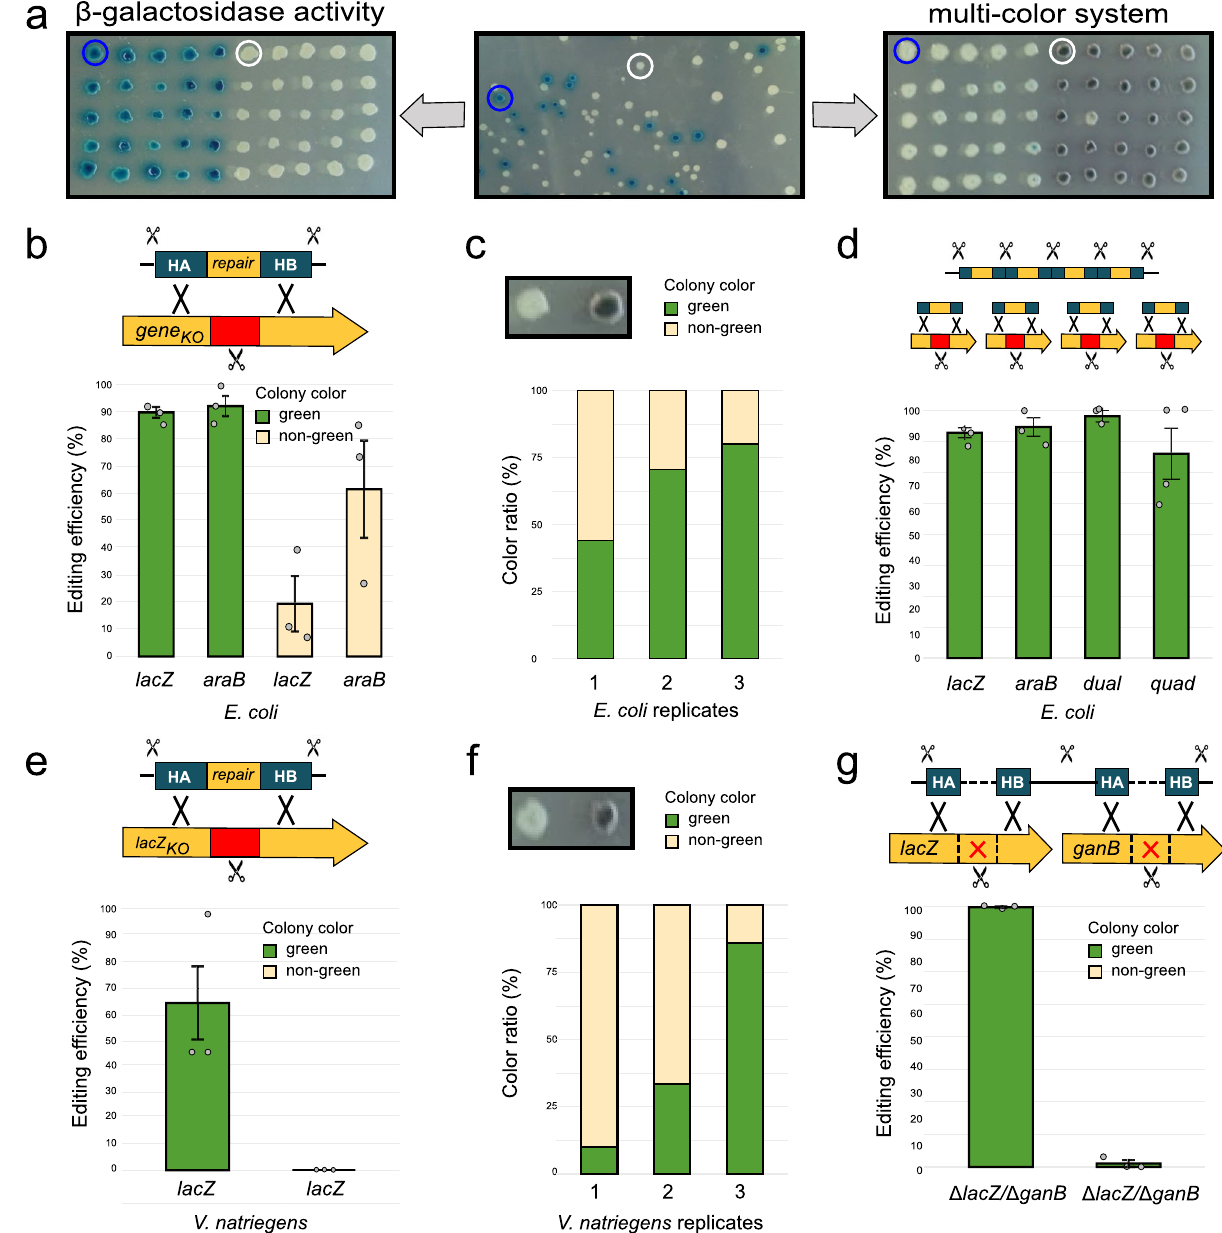
Fig. 4 Editing ef fi ciency of CRISPR SWAPnDROP in three species. a Test of the multi-colour system by a β -galactosidase knockout in Dickeya dadantii . In the left panel, β -galactosidase positive and negative colonies are picked after editing (centre panel) and grown at 37 ∘ C on LB agar supplemented with IPTG and X-Gal. The same colonies were also transferred to a second plate and grown on LB at 30 ∘ C to develop the green colour (right panel). Circles indicate identical colonies on three plates. White colonies in the left and centre panels indicate successful editing. b Shown is the editing ef fi ciency of green and non-green colonies for the reconstituted lacZ and araB genes in E. coli . Experiments were carried out in triplicates. 45 green and 45 non-green colonies were tested in total for both lacZ and araB reconstitution. Data are presented as mean values± SEM. c Shown is the colour distribution of colonies in three different lacZ reconstitution experiments. d Shown is the editing ef fi ciency of green colonies of single and multiplex editing. Error bars represent the standard error. Experiments were carried out in triplicates, except for the quadruple edit, which was carried out in quadruplicates. For dual editing ( lacZ and araB ), 45 colonies and for the quadruple edit ( lacZ , araB , xylA and dapA ), 40 colonies were tested in total. Data are presented as mean values ± SEM. e Shown is the editing ef fi ciency of green and non-green colonies for the reconstituted lacZ gene in V. natriegens . Experiments were carried out in triplicates. In total, 43 green and 32 non-green colonies were tested. Data are presented as mean values ± SEM. f Shown is the colour distribution of colonies in three different lacZ reconstitution experiments in V. natriegens . Error bars represent the standard error. g Shown is the editing ef fi ciency of green and non-green colonies for the double knock-out of lacZ and ganB genes in D. dadantii . Experiments were carried out in triplicates. 75 green and 75 non-green colonies were tested in total. Data are presented as mean values ± SEM. Source data are provided as a Source data fi le.